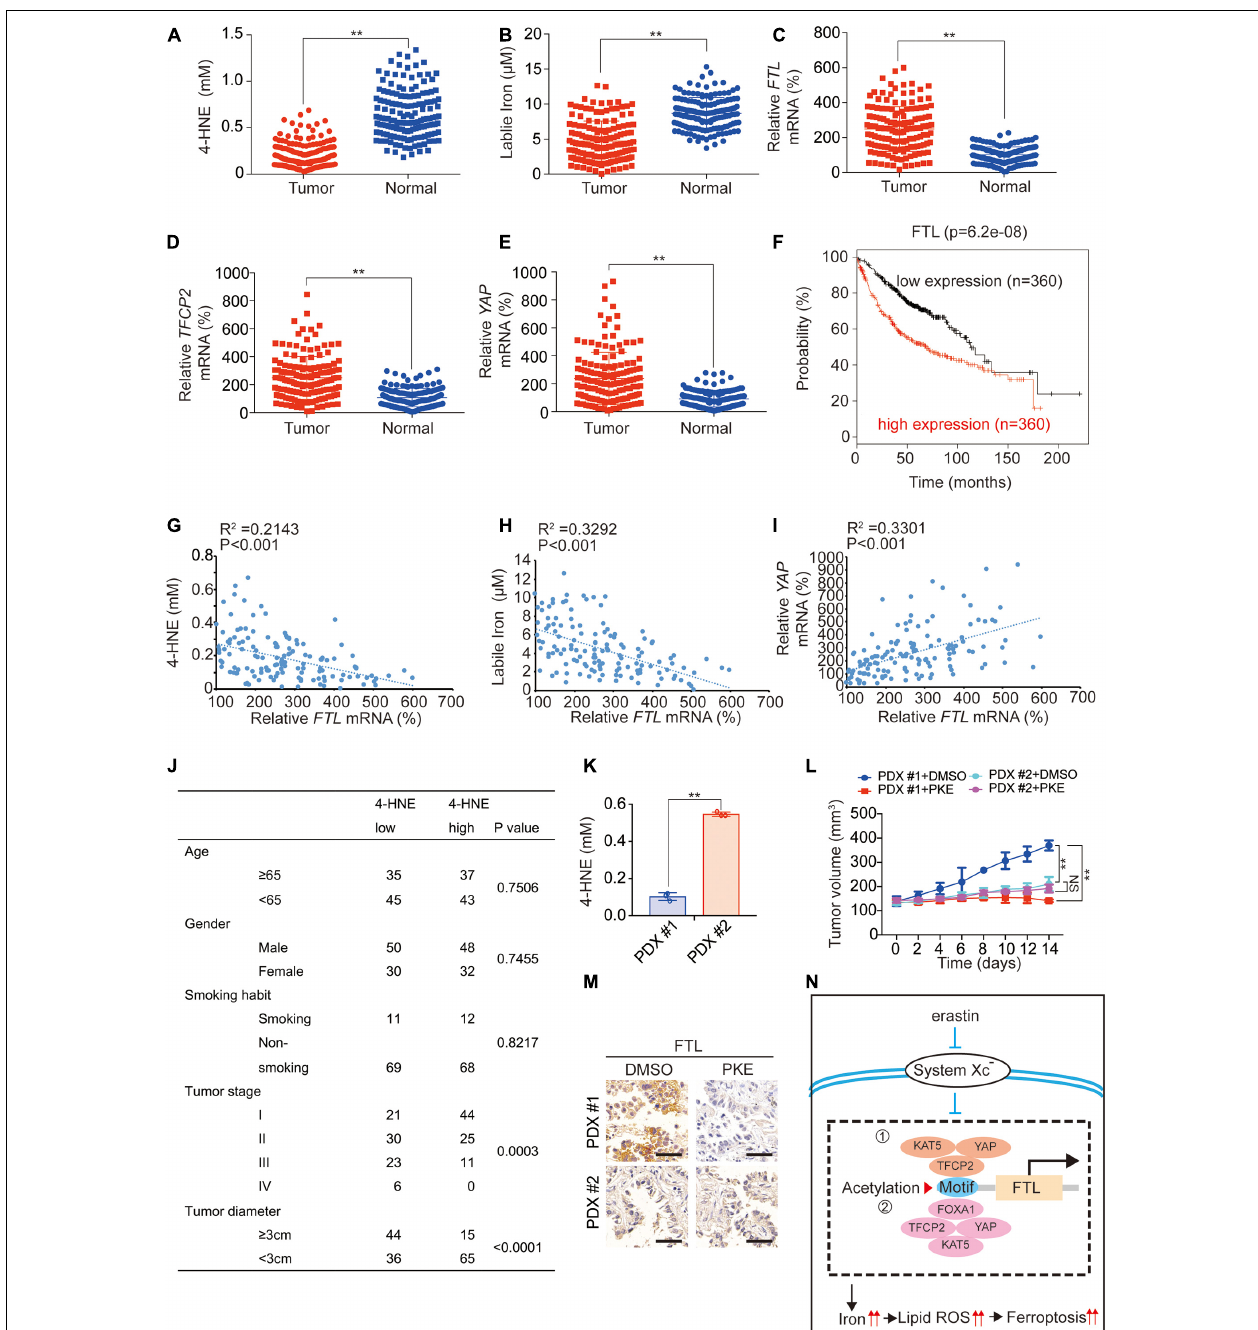
FIGURE 7 | Clinical significance of the study. 4-HNE (A) , labile iron (B) , mRNA levels of FTL (C) , TFCP2 (D) and YAP (E) were analyzed in LUAD tumor ( N = 150) and adjacent normal ( N = 150) tissues. (F) Kaplan–Meier survival plots of FTL were obtained from the KM plotter database. (G–I) Analysis of correlation between FTL mRNA and 4-HNE (G) , labile iron (H) as well as YAP mRNA (I) . (J) Association between 4-HNE level and clinicopathological parameters including age, gender, smoking habit, tumor stage and tumor diameter. (K) 4-HNE level in PDX#1 and PDX#2 before PKE treatment. (L) Volume of PDX for indicated times after treating with or without PKE (5 mg/kg) once every day for 14 days ( n = 8/group). (M) FTL expression was measured in PDX model with or without PKE (5 mg/kg) treatment at day 14 by IHC. Scale bar, 200 µ m. (N) The model of the study. When system Xc − is inhibited by erastin, the acetylation induced by YAP-TFCP2 dependent transcription ( (cid:192) TFCP2 as the transcription factor; (cid:193) YAP and TFCP2 co-regulated FOXA1 as the transcription factor) of FTL promoter is inhibited, which suppressed the transcription of FTL . This further leads to a labile iron and ferroptosis sensitivity elevation in LUAD cells. The data are shown as the mean ± SD from three biological replicates. ** P < 0.01 indicates statistical significance. Data in A-E, K were analyzed using student’s t -test. Data in (G-I) were analyzed using Spearman rank-correlation analysis. Data in (L) were analyzed using a two-way ANOVA test.